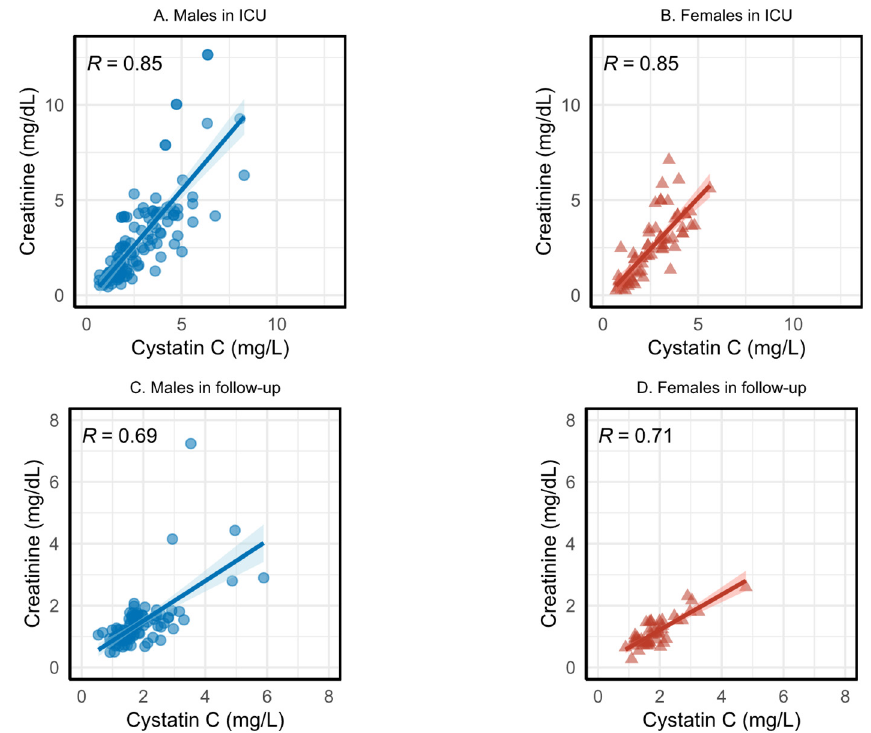
Figure 1. Spearman correlation coefficient for males and females for serum creatinine (SCr) and cystatin C (CysC) in the intensive care unit (ICU) stay and follow-up phases. ( A , B ) show correlation coefficient for males and females for SCr and CysC in the ICU stay, respectively. ( C , D ) shows correlation coefficient for males and females for SCr and CysC in the follow-up phase, respectively.